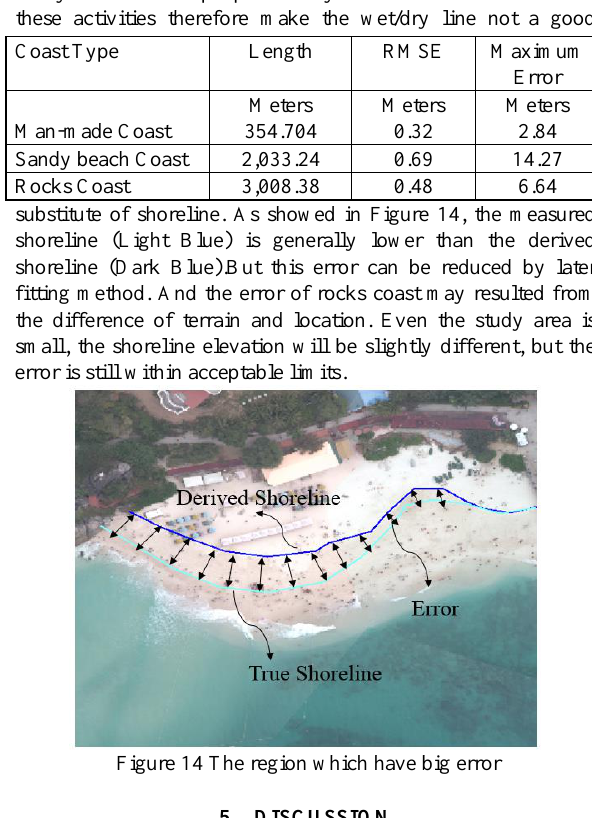
Table 4: Accuracy assessment of proposed method.